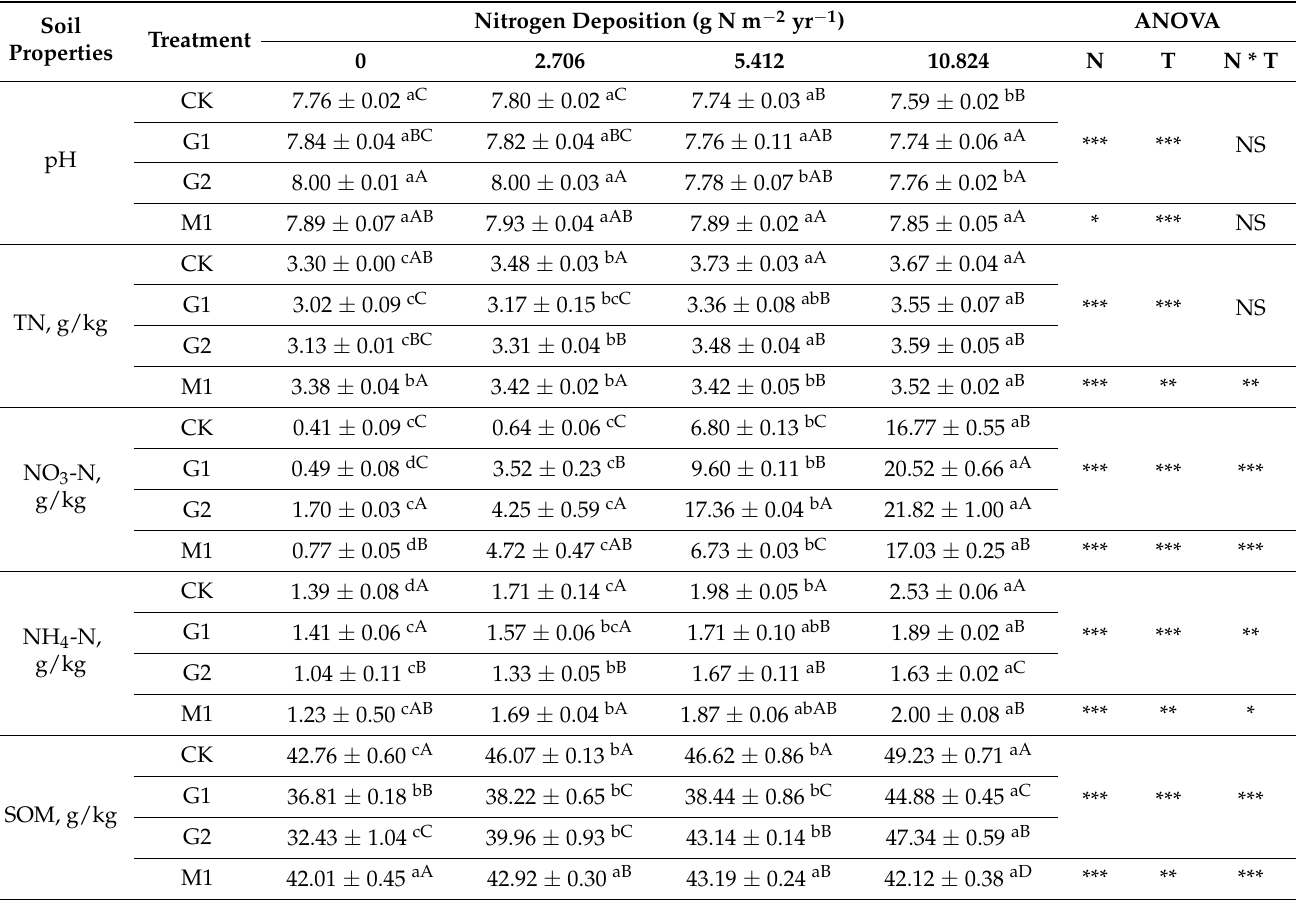
Table 1. Soil properties of grazing sheep and mowing grasslands in the context of different levels of nitrogen